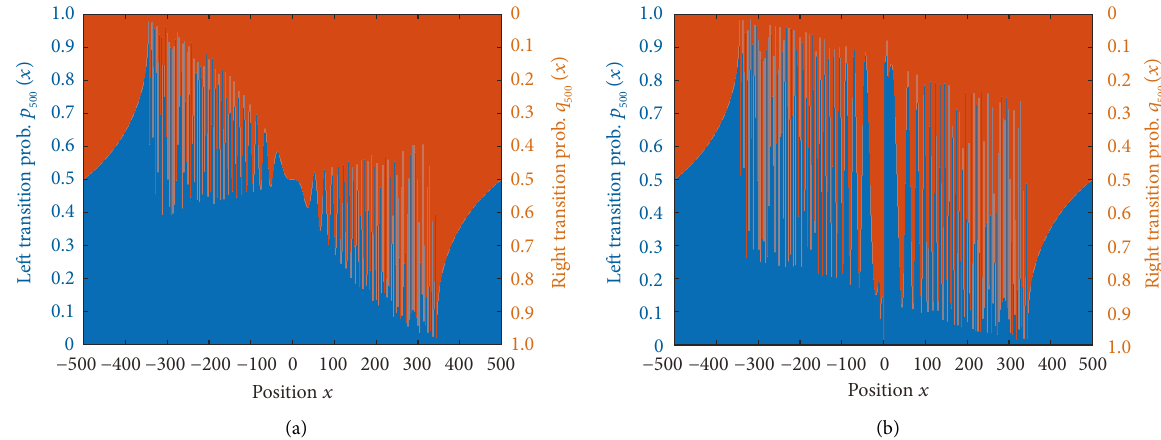
Figure 5: Transition probabilities p (one-defect). It holds that p stacked bar